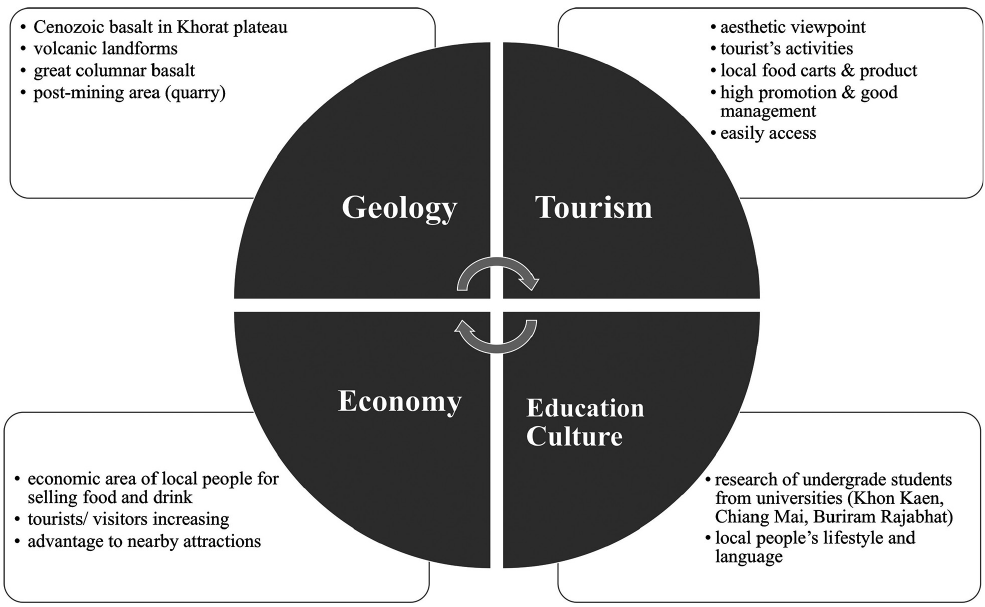
Fig. 7. The model of alkaline columnar basalt in Buriram Terrain,